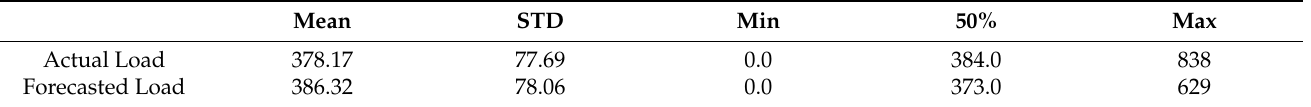
Table 2. Montenegrin power consumption (load) descriptive statistics, ENTSO-e